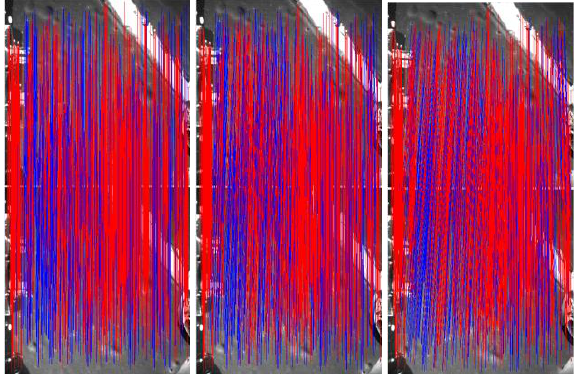
Figure 4. The matching results between sequential images In this experiment, GCPs were selected from LRO and SLDEM data for geo-registration and drift error elimination. Since the coordinates of GCPs from the data were geodetic coordinates, they should be transformed into Cartesian coordinates.